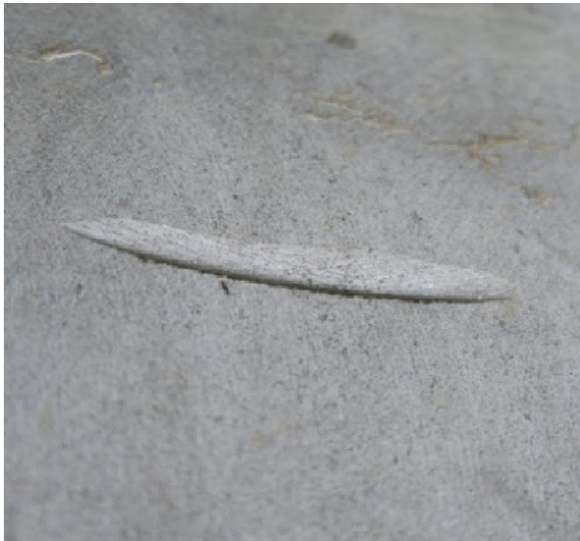
Fig. 14 Image for testing